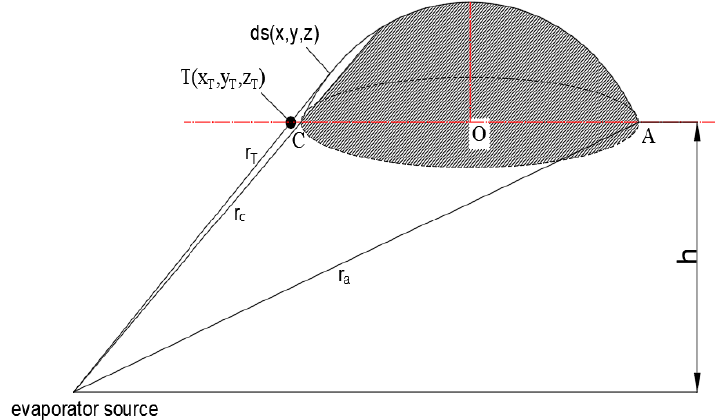
Figure 2. Schematic diagram illustrating the outer contour shielding of the reflective mirror.